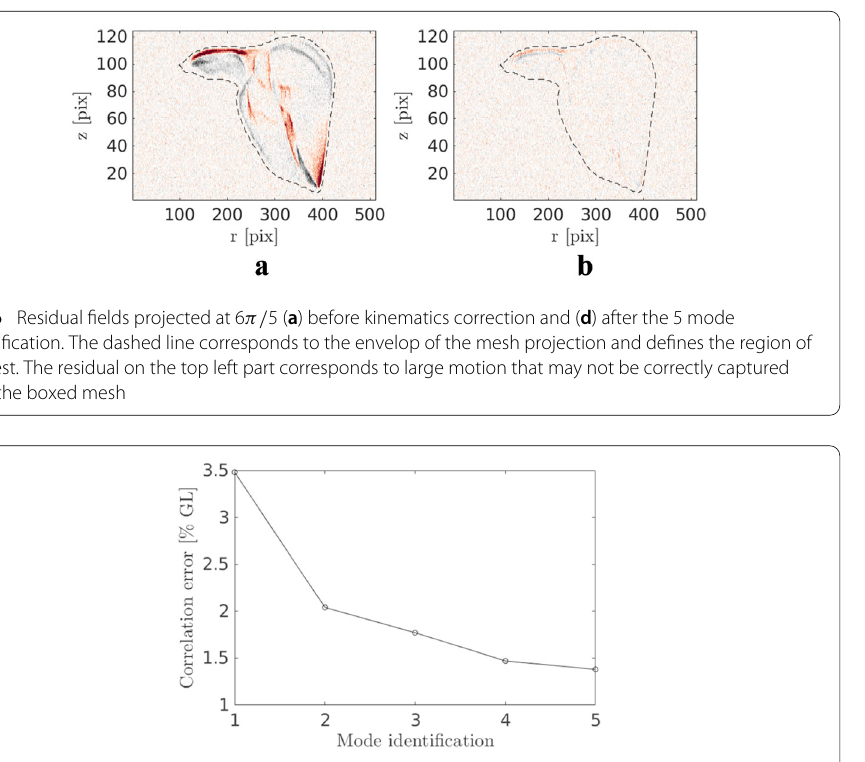
Fig. 7 Evolution of the residual norm at each iteration. The residual converges after 4–5 modes meaning that no additional mode are